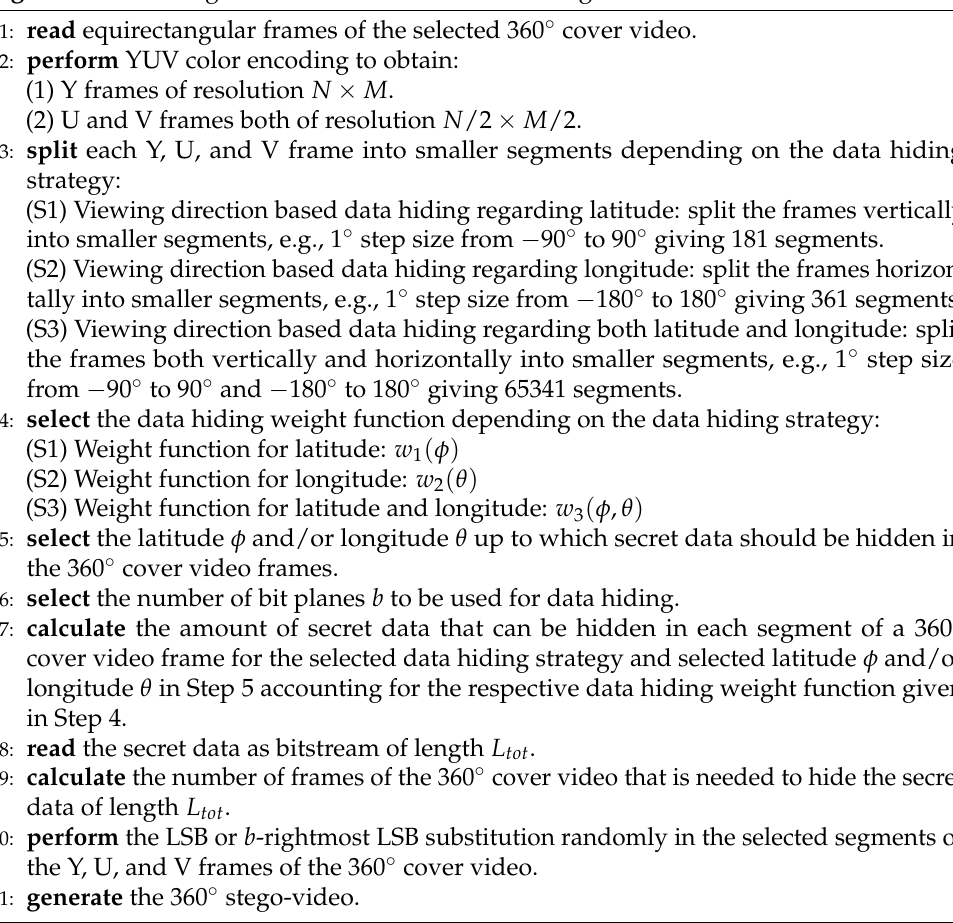
Algorithm 1 Viewing Direction Based LSB Data Hiding in 360 ◦